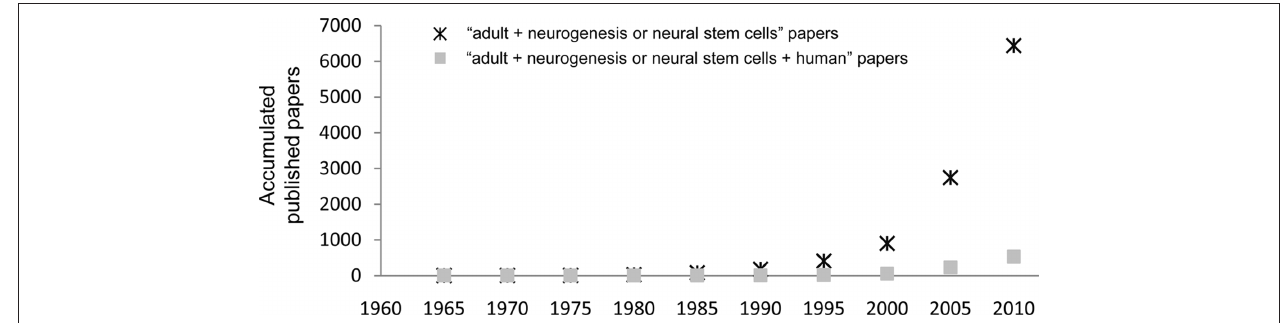
FigUre 1 | Published papers on adult neurogenesis per quinquennium. The graph shows the accumulated papers published from 1960 onward, searched in PubMed with the search terms “adult” AND (“neurogenesis” OR “stem cells”). The asterisks show the total number of papers, and the filled squares show those papers with the term “human” in their